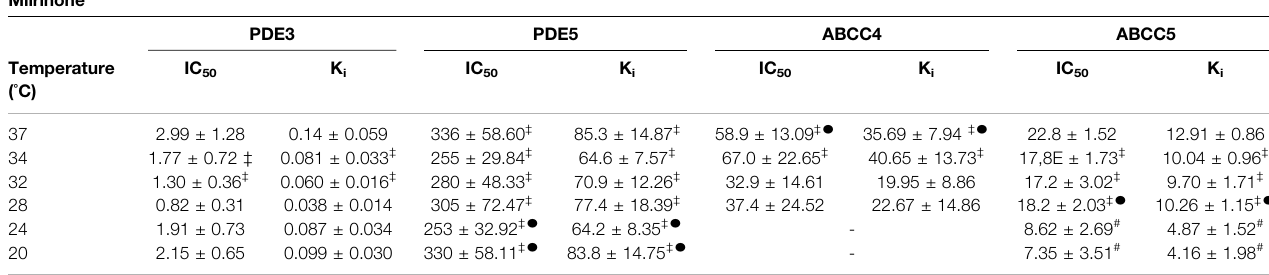
TABLE 1 | IC 50 and K i values for inhibition of PDE3, PDE5, ABCC4, and ABCC5 at temperatures ranging from 37 ° C to 20 °